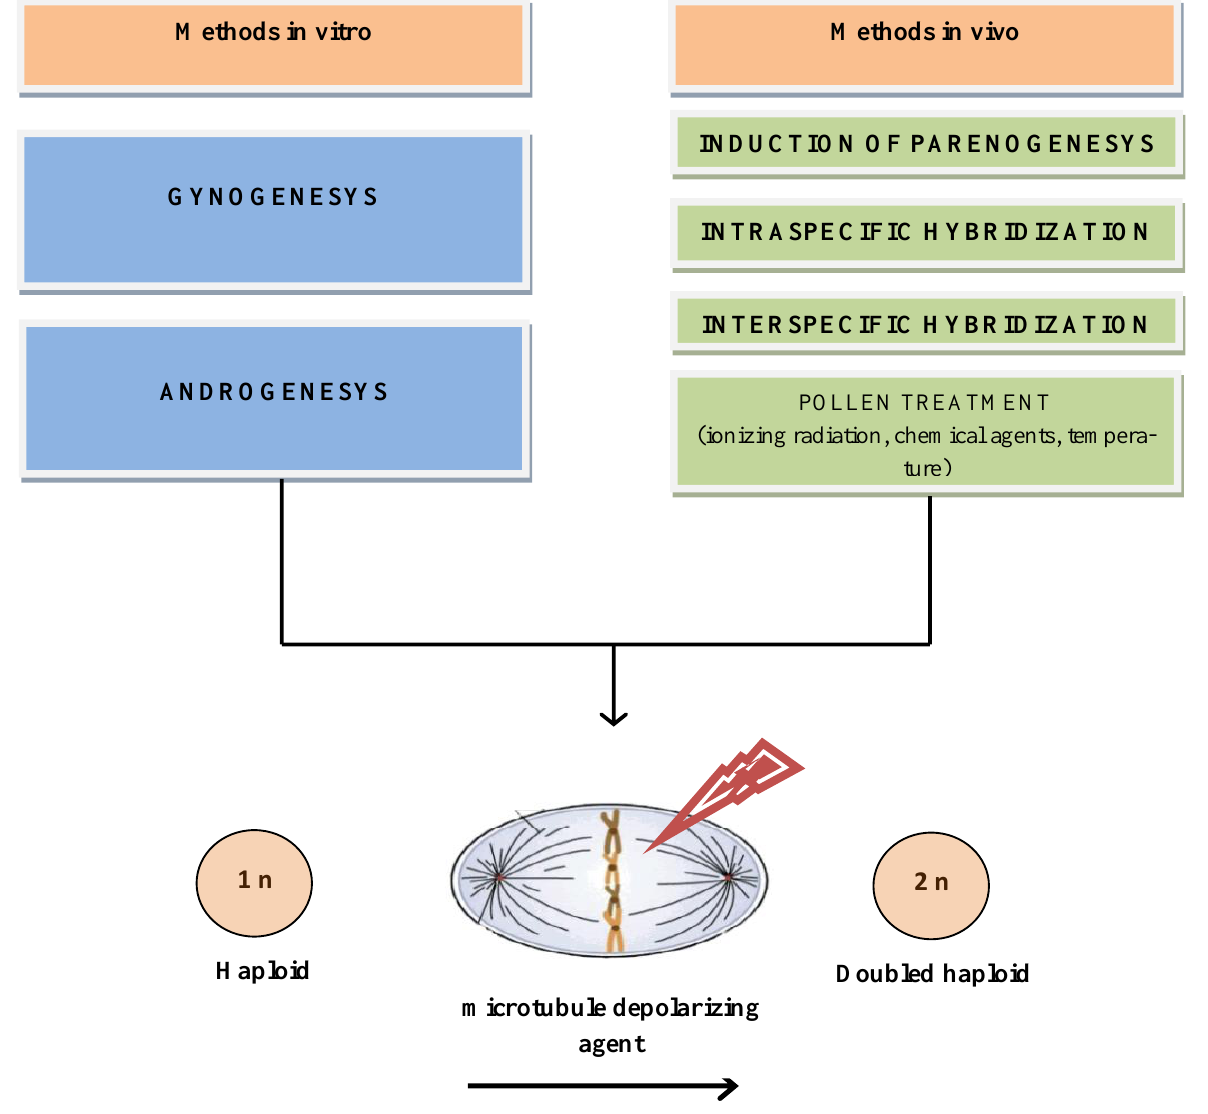
Figure 1. Representation of the methods of haploidy induction in Figure 1. Schematic representation of the methods of haploidy induction in plants. 100